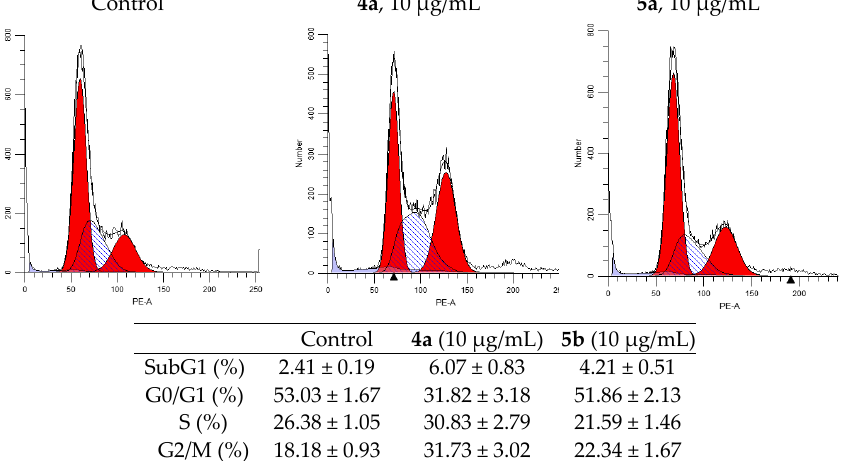
Figure 5. Effect of spiro-fused tryptanthrines and pyrrolo[3,4- a ]pyrrolizines 4a and 5a on the distribution of HeLa cells in the cell cycle.